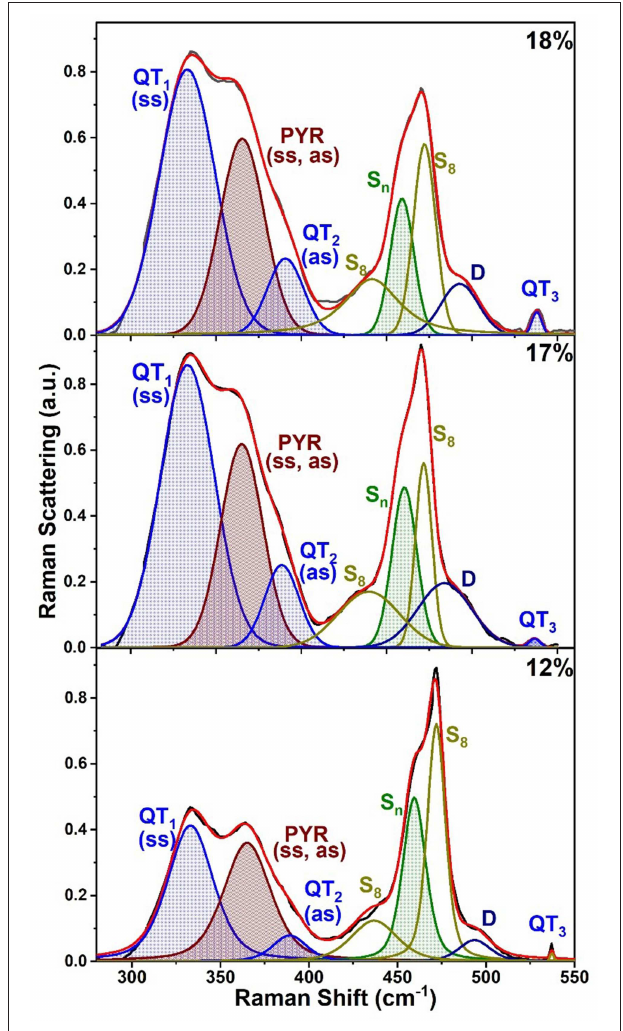
FIGURE 8 | FT Raman results on (A) c-As 2 S 3 (Orpiment) and c-As 4 S 4 (Realgar), (B) As x S 100 − x bulk glasses at high As content in the 40% < x < 24% range, and in (C) at low As content in the range 20% < x < 12% and of crystalline—Sulfur. In (C) we observe the three expected modes of QT S = As(S 1 / 2 ) 3 local structures labeled QT 1 , QT 2, and QT 3 , and the modes of PYR As(S 1 / 2 ) 3 local structure labeled PYR. These modes occur at frequencies close to those predicted by NRLMOL calculations (Table 1) . In (B) at x = 40%, the four observed modes labeled O with indicated mode frequencies in cm − 1 are due to Orpiment—like features, and are systematically blue shifted wrt to the O-modes in c-As 2 S 3 in (A) by about 14 to 21 cm − 1 . The stoichiometric glass (x = 40%) also displays 3 modes labeled R that occur at frequencies reasonably close to those observed in c-As 4 S 4 as in (A) . Feature D near 490 cm − 1 is observed over a wide range of x, 12% < x < 33%. The observation of R modes in the x = 40% glass shows the stoichiometric glass is mildly NSPS as noted earlier by Georgiev et al. (2003b). In (B) modes of QT species steadily go over into those of O—species as x increases from 24 to 40%. Modes of polymeric S n chains (461 cm − 1 ), and of monomeric S 8 species (217 cm − 1 , 472 cm − 1 ) are observed as expected. See text.